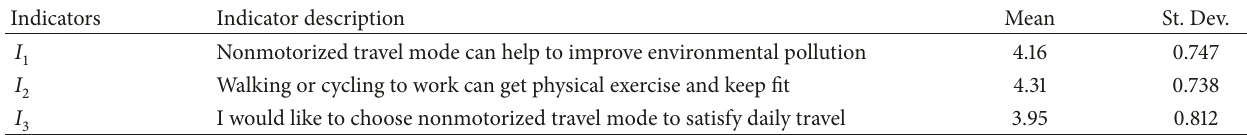
Figure 3: Indicators of latent variable. Table 2: Latent variable and indicators.